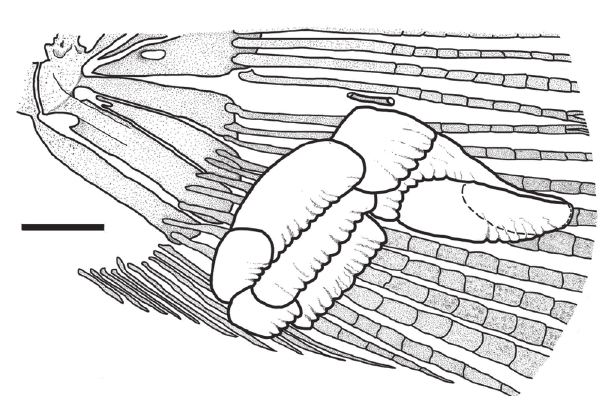
Fig. 4. Chrysobrycon eliasi , male, AI 287, 39.9 mm SL. Lateral view of the caudal fin, left side. Note the squamation associated to pouch scale in the ventral lobe. Scale bar = 1